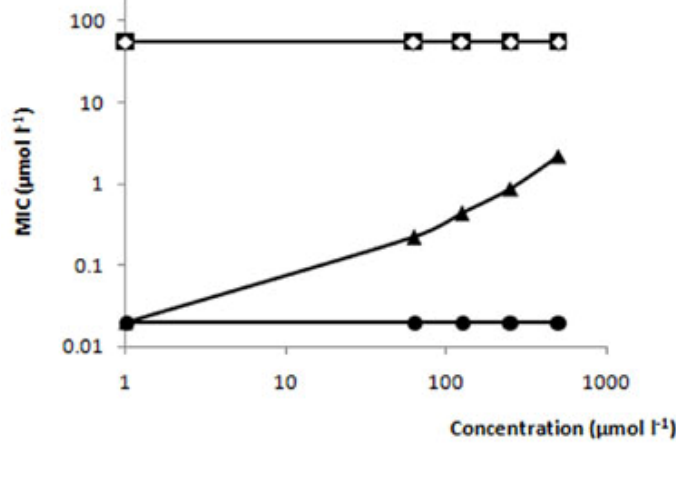
Figure 2 . Effect of ergosterol on the MIC of TIO C against T. mentagrophytes. (  ) TIO C ; (  ) TIO C + Ergosterol; (  ) Amphotericin B; (  ) Amphotericin B +